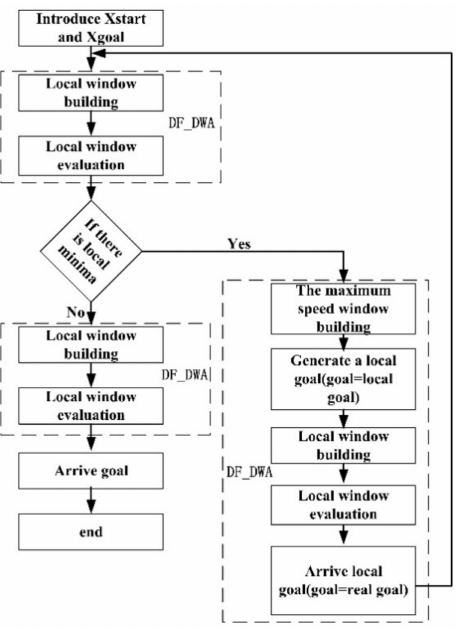
Figure 2. The DF_DWA